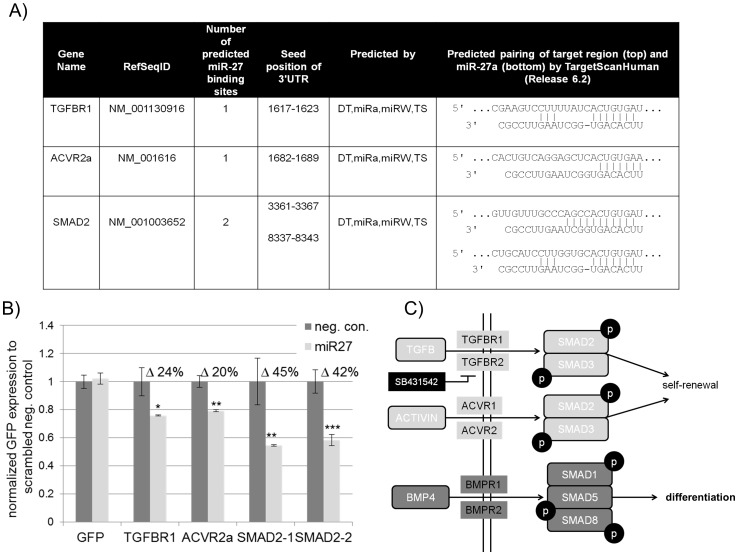
miR-27 directly inhibits a number of genes of the TGFß signalling pathway that promote self-renewal in undifferentiated embryonic stem cells. (A) Table shows putative miR-27 target genes associated with TGFß-signalling as predicted by Diana Micro-T (DT), MiRanda (miRa), MirWalk (miRW) and TargetScan. (B) Normalized GFP expression (48 hours post transfection) of HEK293 cells co-transfected with EGFP-sensors bearing parts of the 3′-UTR of TGFßR1, ACVR2a, SMAD2 or the 3′-UTR of the empty eGFP-vector (lane 1)together with either miR-27 mimics or a scrambled negative control mimic (neg. con.). All transfections were performed twice in biological triplicates (n = 6). An unpaired two tailed t-test was performed to reveal significant differences (*p<0.05, ** p<0.01, *** p<0.001). (C) Schematic representation of the TGFß-signalling cascade adopted from the KEGGs pathway database (www.genome.jp/kegg/pathway.html).